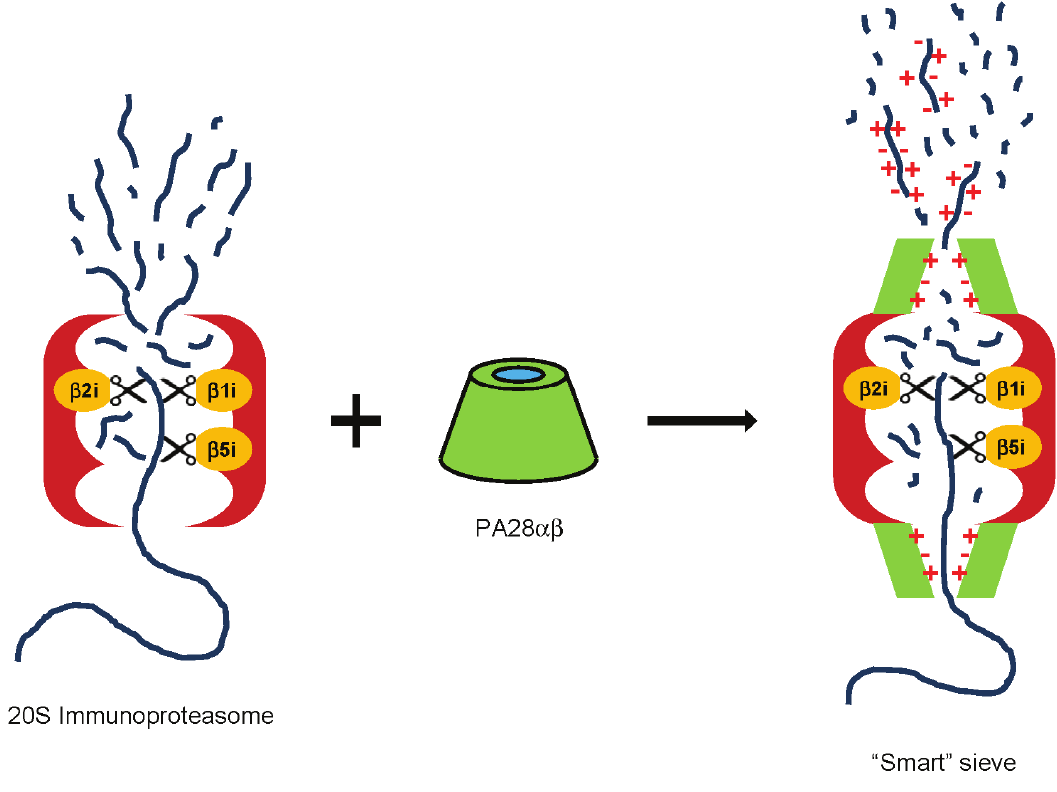
Figure 2. “Smart” sieve model for biochemical activity of PA28(cid:2)(cid:3). See text for more